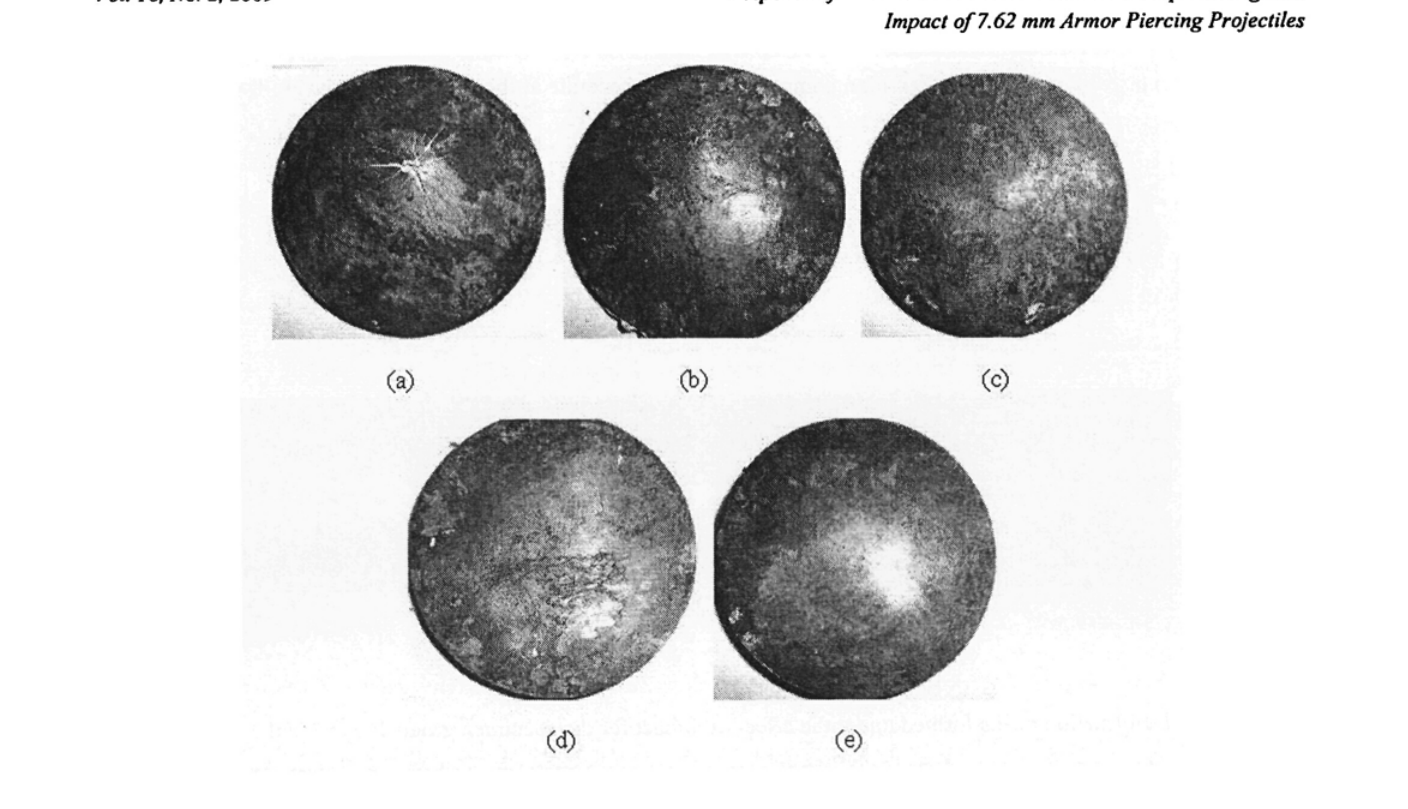
Fig. 7: Rear views of the specimen group 3 a) 55, b) 70, c) 85, d) 100 and e) 115 kg/m 2 after ballistic testing.